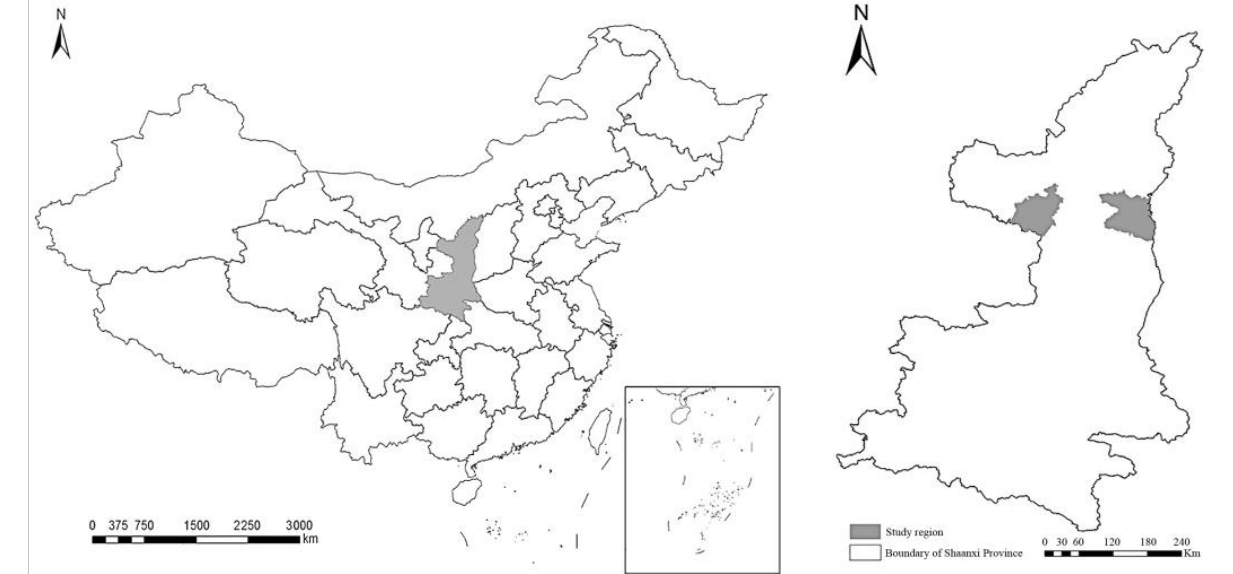
Figure 1. Location of study region.